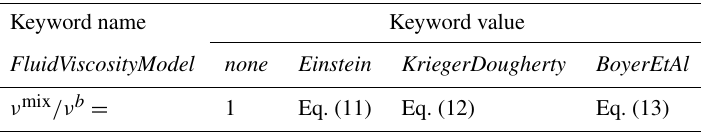
Table 2. List of the mixture viscosity model that can be selected through the keyword FluidViscosityModel together with model equation